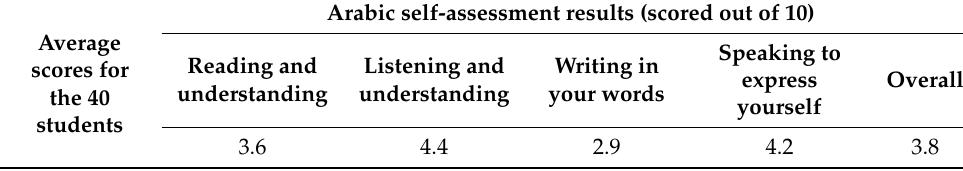
Table 4. Averaged self-assessments of Arabic